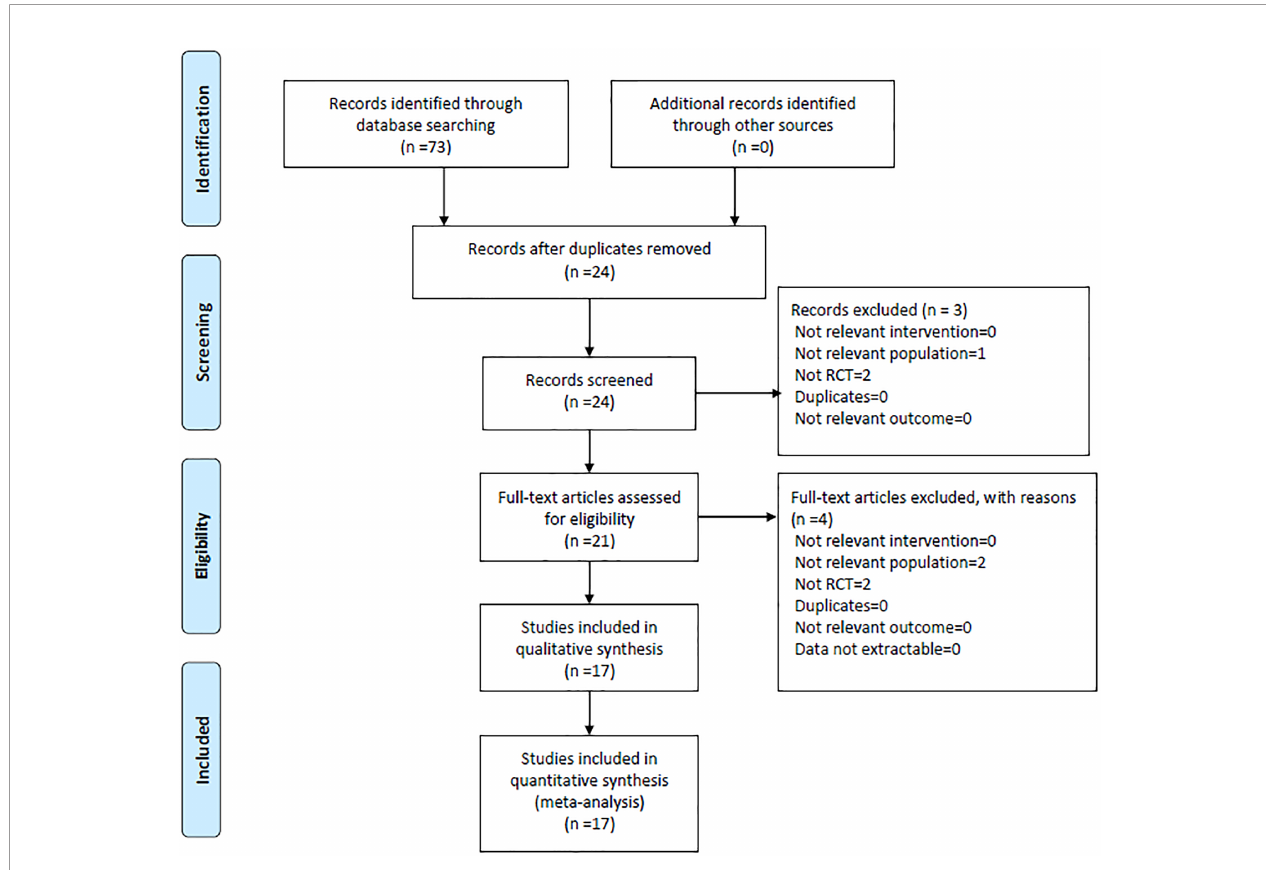
FIGURE 1 | Flow diagram of the study selection